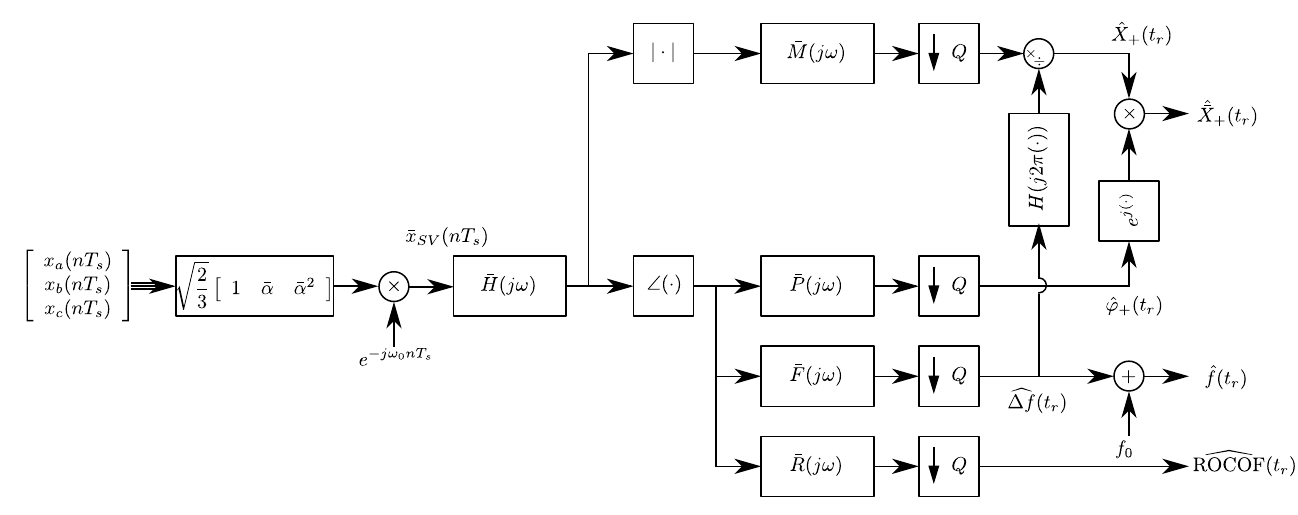
Figure 2. Block diagram of the SV-F